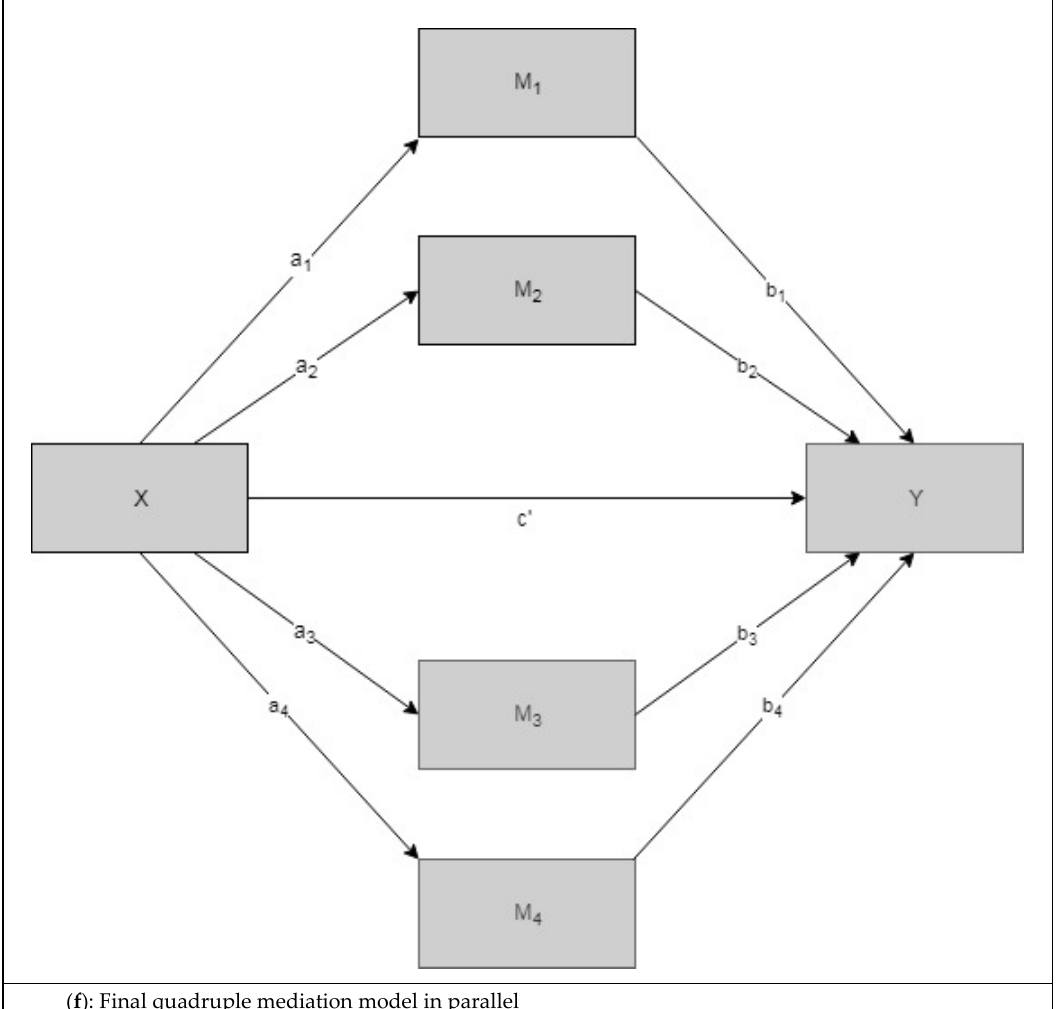
Figure A2. Different mediation steps testing the relationships of the variables. Figure A2. Di ff erent mediation steps testing the relationships of the